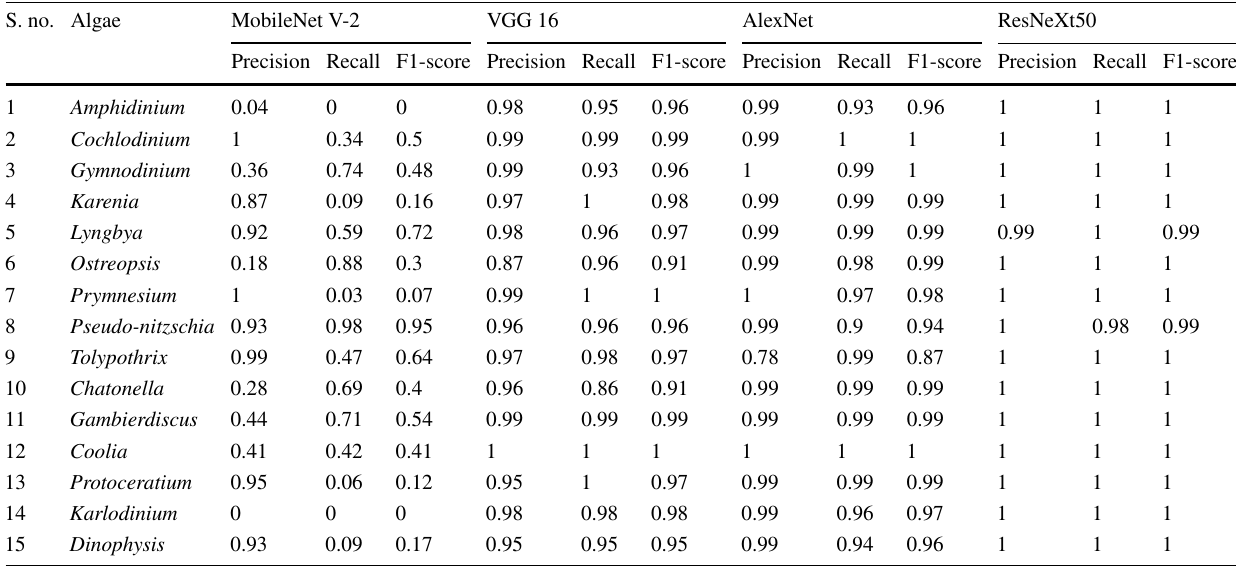
Table 1 The F1-score, precision, and recall values for the studied models S. no.